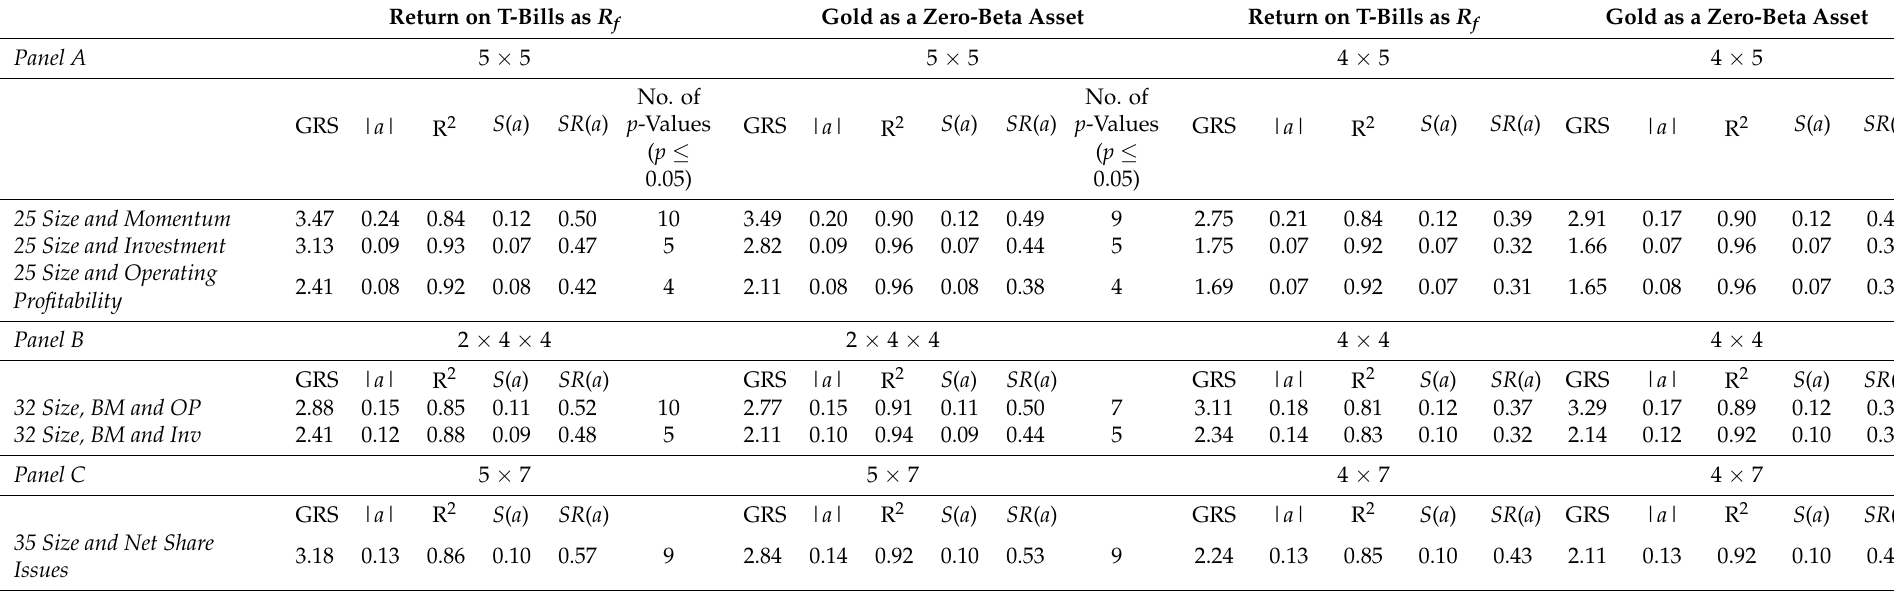
Table 16. Statistical summary of the GRS test to explain five-factor and G-five-factor regressions from January 1981 to December 2015. The GRS statistic tests the null hypothesis that the alphas of all portfolios are jointly equal to zero. | a | is the average absolute alpha; R 2 is the mean-adjusted R-squared; s ( a ) is the mean standard error of alphas; and SR ( a ) is the average Sharpe ratio of alphas. The critical values for GRS statistic are 90%: 1.41; 95%: 1.56; 97.5%: 1.69; 99%: 1.86, and 99.9%: 2.25. Panel A shows results on 25 size and momentum, size and investment, 25 size and operating profitability with (5 × 5) and without microcaps (4 × 5), Panel B shows results on 32 size, book-to-market, and operating profitability and 32 size, book-to-market, and investment portfolios with (5 × 5) and without microcaps (4 × 5), and Panel C shows results on 35 size and net share issues portfolios with (5 × 5) and without microcaps (4 × 5). Return on T-Bills as R f Gold as a Zero-Beta Asset Return on T-Bills as R f Gold as a Zero-Beta